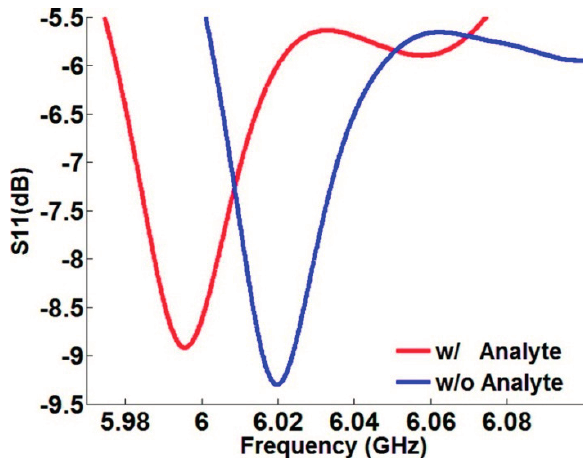
Figure 12. Shifting of the resonance dip in the S 11 spectrum of the sensor prototype, when polymer phantoms of analyte with the relative permittivity of about 2 were inserted in air gaps between